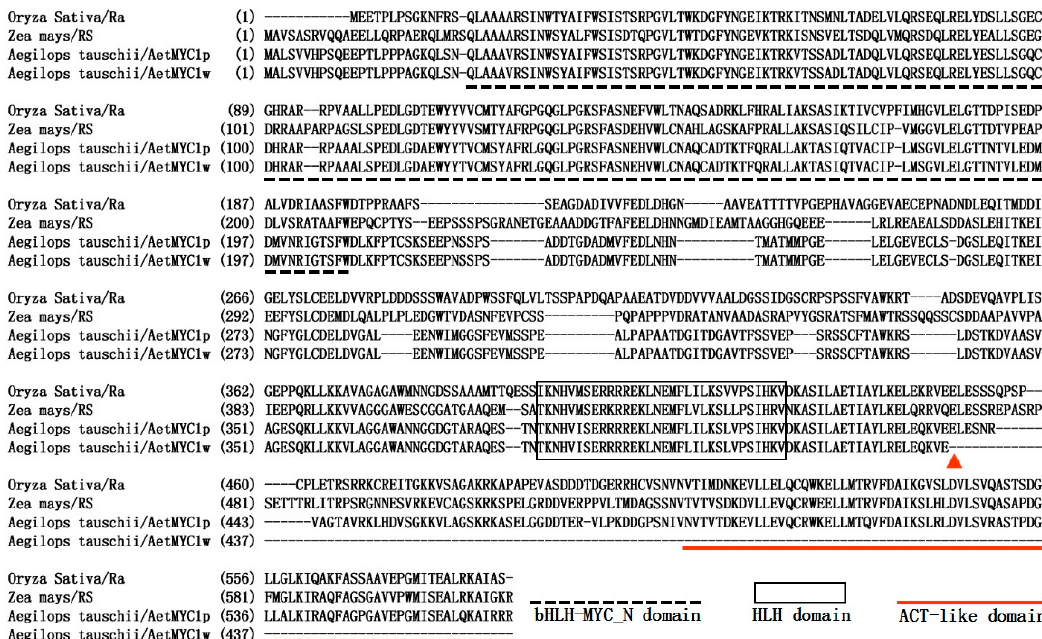
nucleotide differences from that of AetMYC1p from ‘As60’ (Table S3), and encoded 436 amino acids (compared to 567 amino acids encoded by AetMYC1p ) because a single nucleotide mutation at 1310 bp caused premature termination of translation of the encoded protein (Figure 2). As a result of the premature termination, AetMYC1w had lost the ACT-like domain (Figure 2).